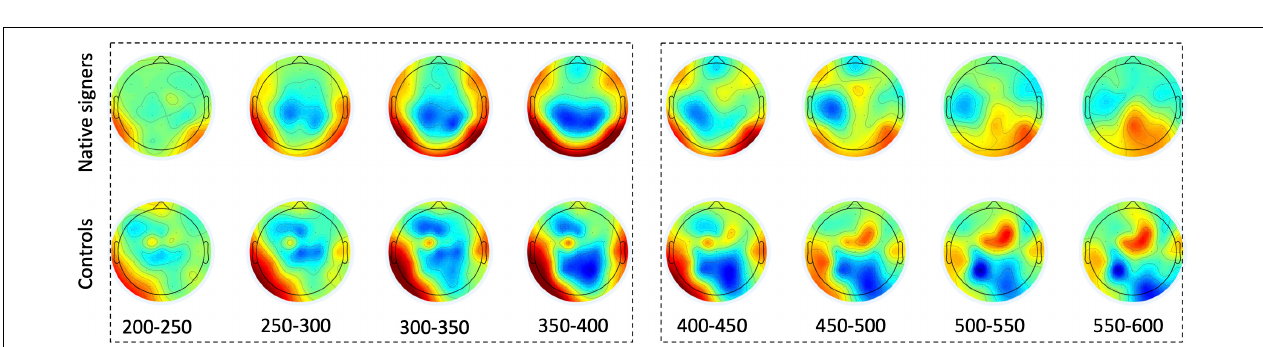
FIGURE 5 | Grand average waveforms for Native signers (left two columns) and Controls (right two columns) for the Overlapping (black line) and Unrelated (gray line) fragments across regions of interest (Anterior, Central, Posterior × Left, Right). In red, the difference wave (Unrelated – Overlapping) as well as an indication of a significant difference from zero (point-by-point; p < 0.01) for the difference waves. Vertical dashed gray lines indicate measurement windows.